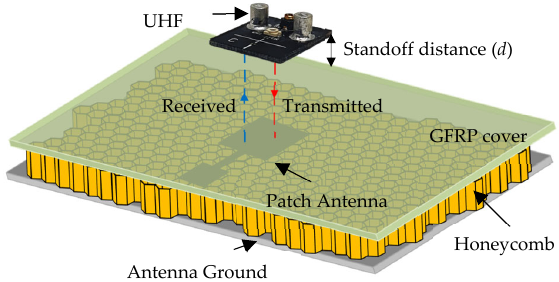
Figure 1. A schematic showing the antenna embedded in a composite structure, and a UHF probe used for inspection of the structure.